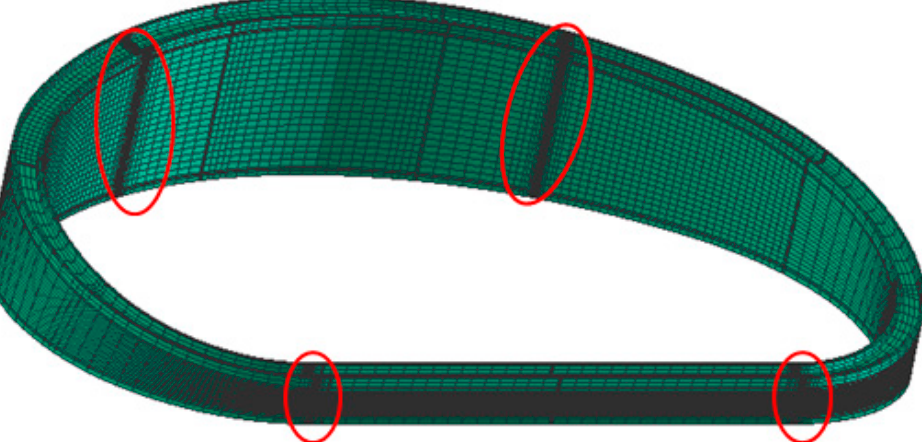
Figure 14. The full-size finite element model of the 1/32 VV mock-up, and the red circles represent the mesh refinement zones.